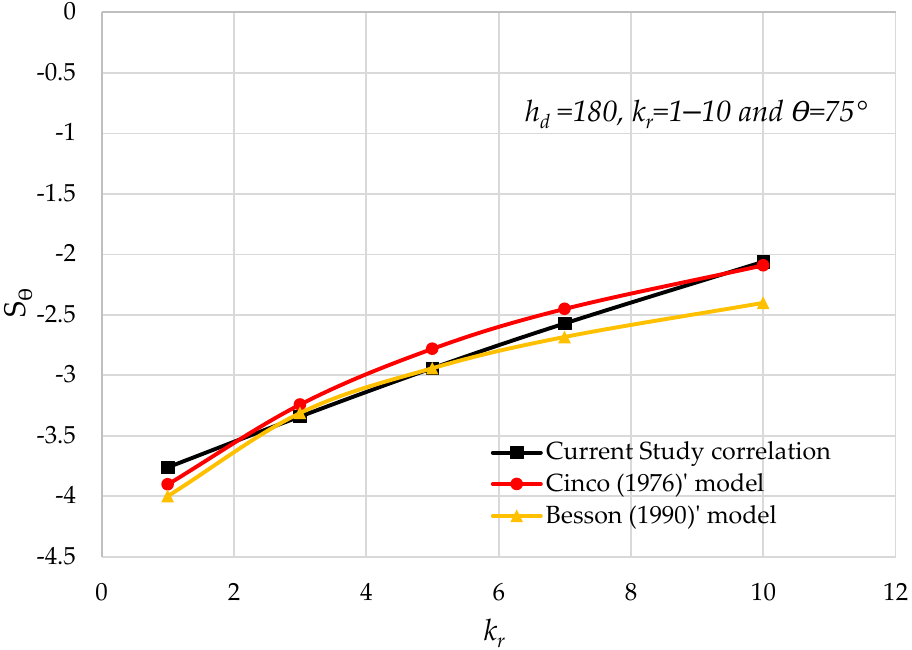
Figure 12. Comparison between the current correlation and the slant skin model results of Cinco et al. (1975) [1] and Besson (1990) [2] for increasing permeability ratio (1–10).